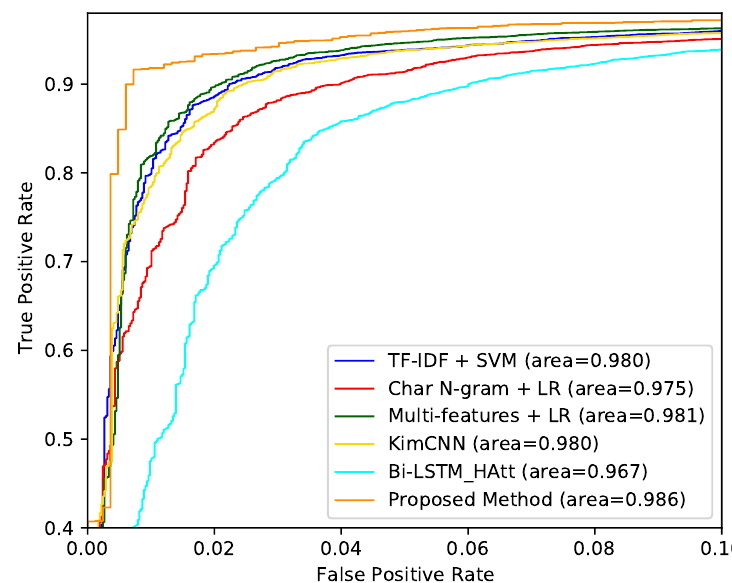
Figure 4. The ROC curve of dataset Tweets [24].